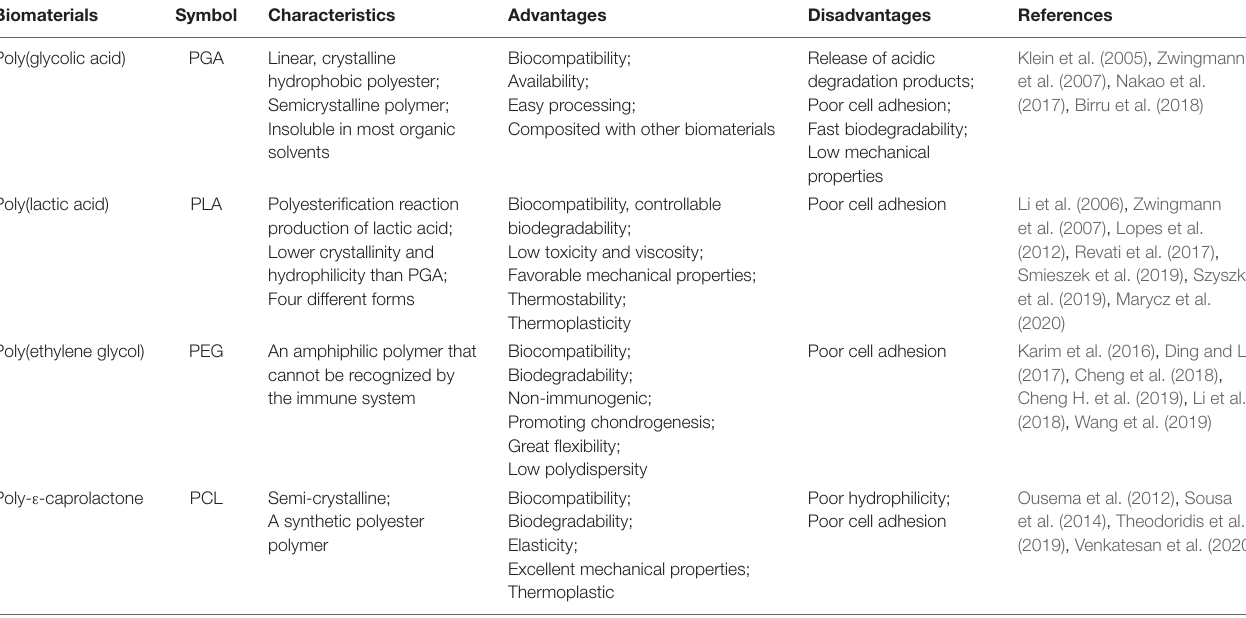
TABLE 2 | Characteristics of the outlined synthetic polymers for CTE.